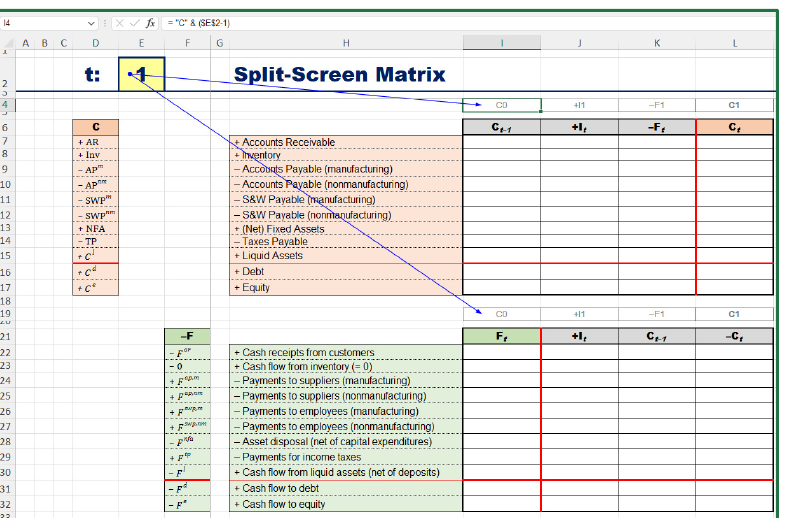
Figure 36. Cell I4 depends on cell E2: if E2 value is t , then I4 value is Ct-1 (e.g., if E2 = 1, then I4 is “C0”). Analogous code for row 19 (“SinglePeriod” sheet)